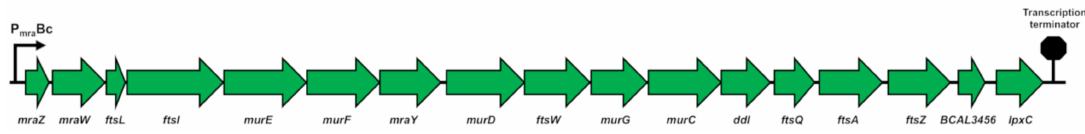
Figure 1. Representation of the 17 genes, and their transcriptional orientation, composing the dcw cluster on chromosome 1 of B. cenocepacia J2315. The main promoter P mra Bc is represented by the black arrow at the 5’ of the operon, whereas the only transcription terminator is localized at the 3’, downstream of lpxC